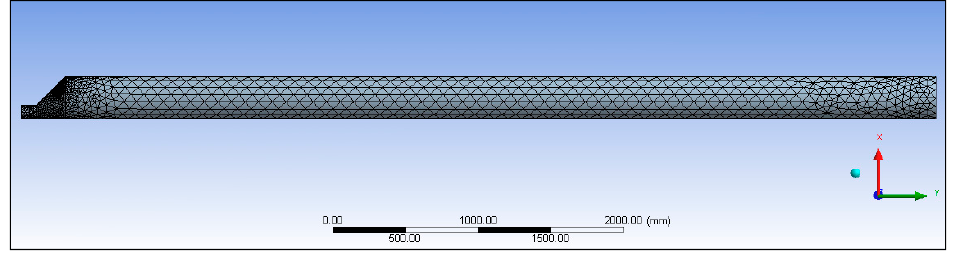
Figure 2. Finite volume model of the pipeline.